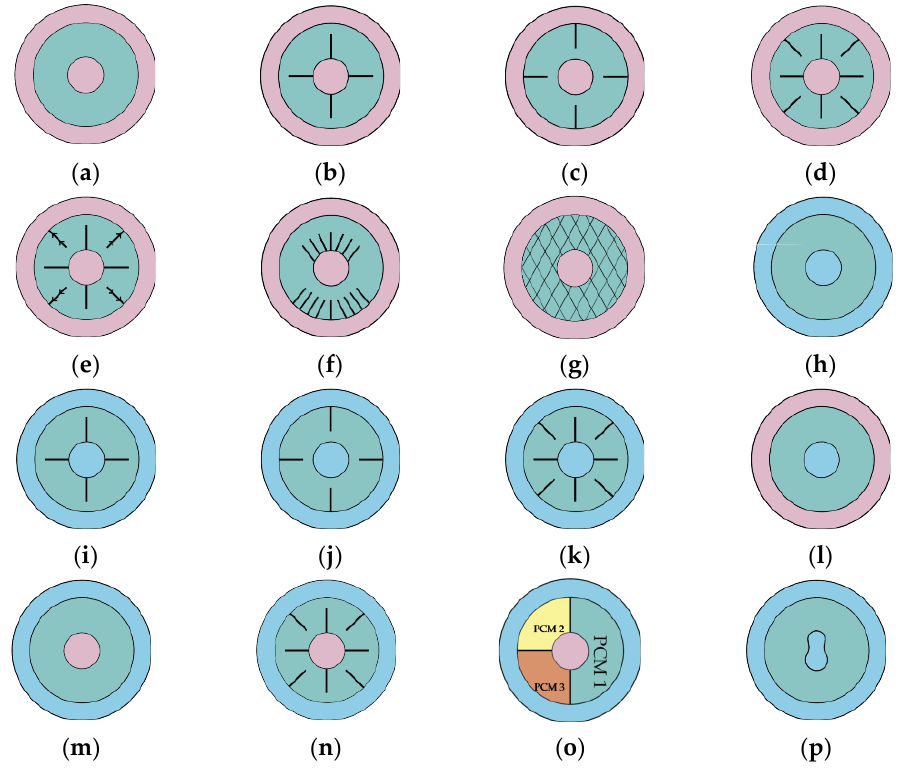
Figure 4. Horizontal triplex-tube arrangements; ( a ) Case TTH-M; ( b ) Case TTH-ILF-M; ( c ) Case